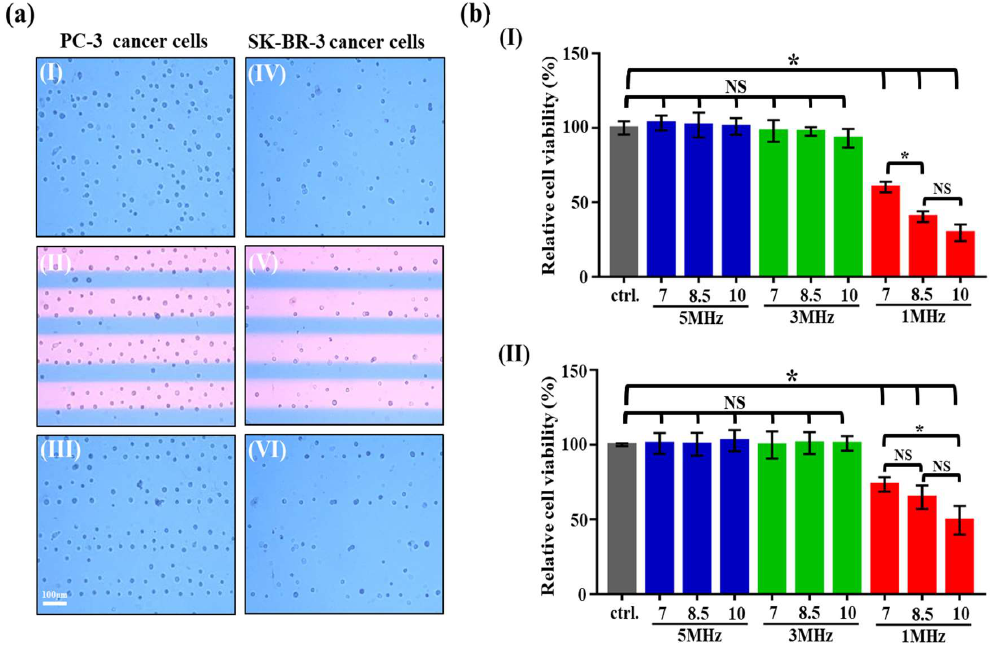
Figure 3. ( a ) Microscopic observation (close-up view) of the cancer cells in the microchamber of the microfluidic chip before (the upper row), during (the middle row), and after (the lower row) treatment with ODEP exposure (the left column—PC-3 cancer cells; the right column—SK-BR-3 cancer cells), ( b ) the comparison of relative cell viability (%) of (I) the PC-3 cancer cells and (II) the SK-BR-3 cancer cells treated with the ODEP field with varied electric conditions (voltage magnitude and frequency: 7, 8.5, and 10 Vpp and 1, 3, and 5 MHz, respectively) (NS—No significant difference ( p > 0.05), * significant difference ( p <